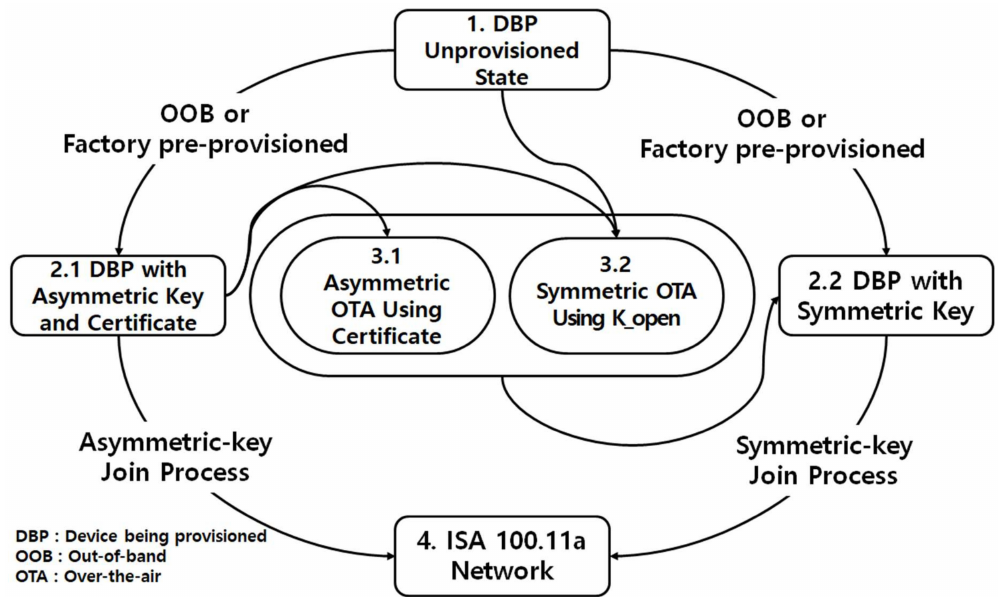
Figure 1. Acquisition of trust-related information as per ISA